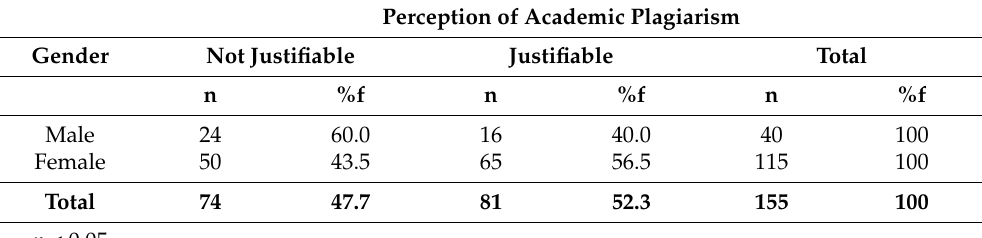
Table 6. Level of perception of academic plagiarism in students at the school of industrial engineering of a public university in Lima according to gender.